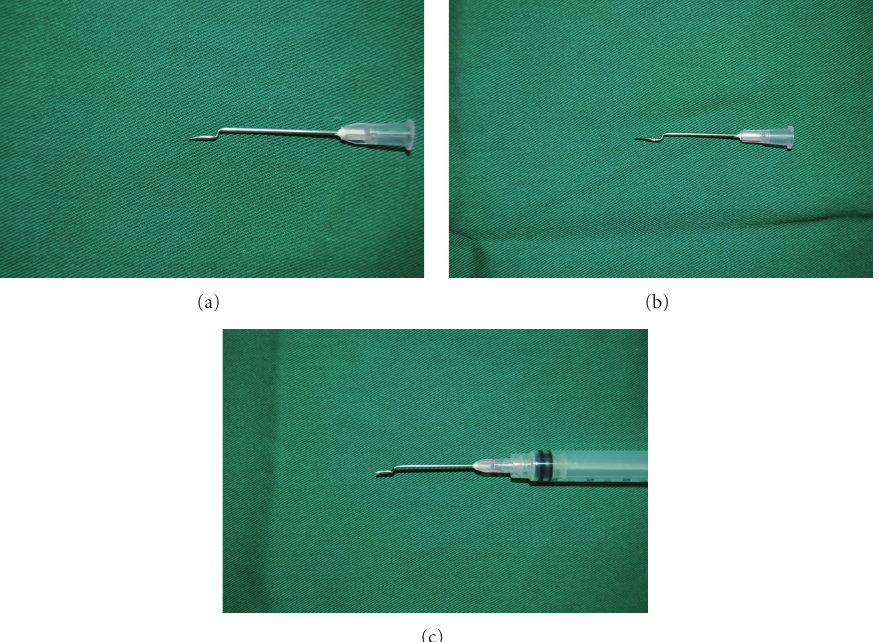
Figure 2: (a) The final shape of the hypodermic needle. (b) The same technique may be applied to a Nokor needle. (c) The modified hypodermic needle attached to a 3cc luer lock